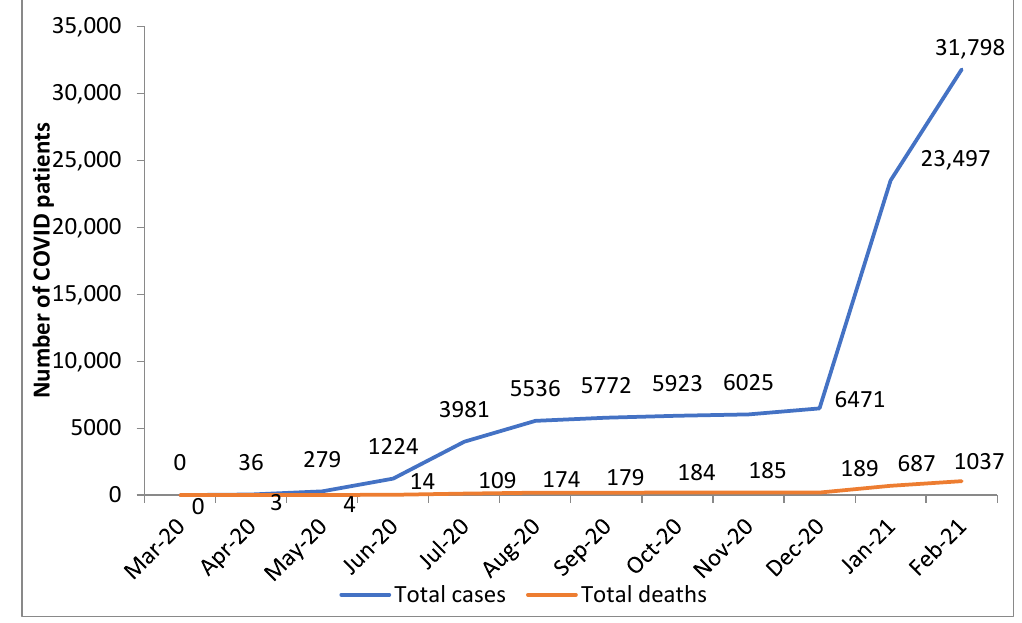
Figure 1. Cumulative number of COVID-19 cases and deaths in Malawi between March 2020 and February 2021 as reported to the World Health Organization.